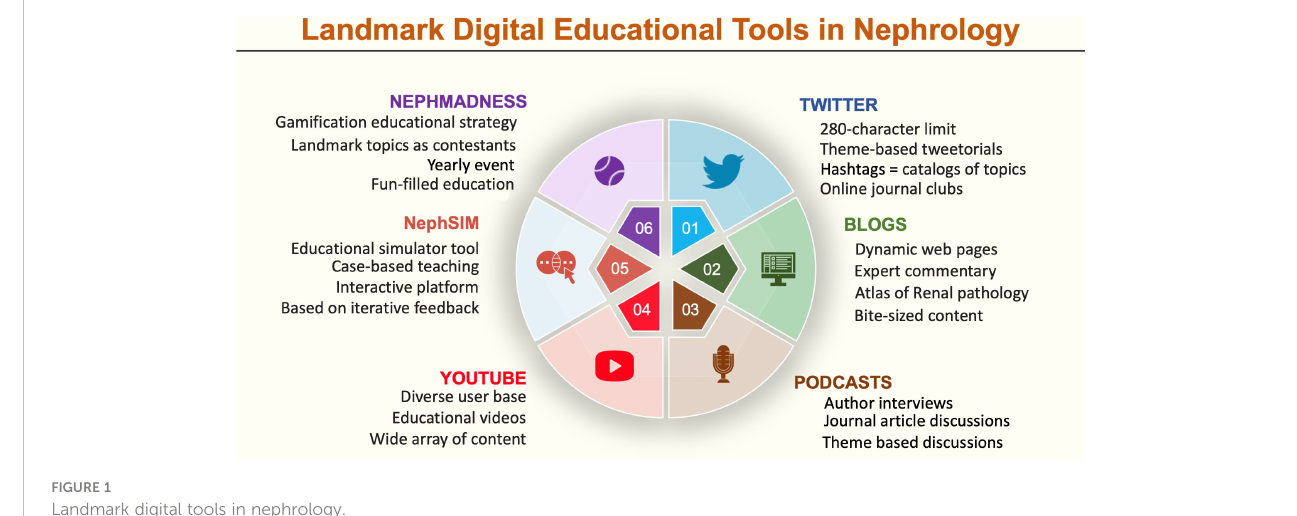
FIGURE 1 Landmark digital tools in